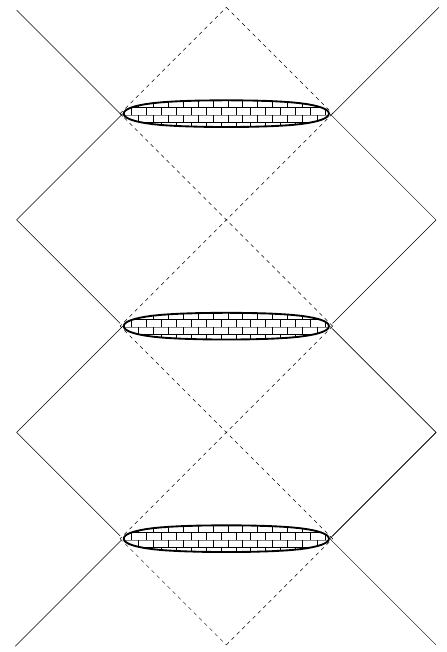
Figure 7. Quantum extension of a Kruskal black hole. While curvature singularities may be removed in models of loop quantum gravity, they are replaced by regions of Euclidean space through which evolution is impossible. The extended space(-time) has unique solutions provided well-posed initial-boundary value problems are used for mixed-type equations. Lorentzian regions have finite boundaries at their transition hypersurfaces to Euclidean regions, which are non-singular but require boundary values that are interpreted as future data from the Lorentzian perspective. The extension shown here is derived from covariance together with consistency with deterministic behavior at low